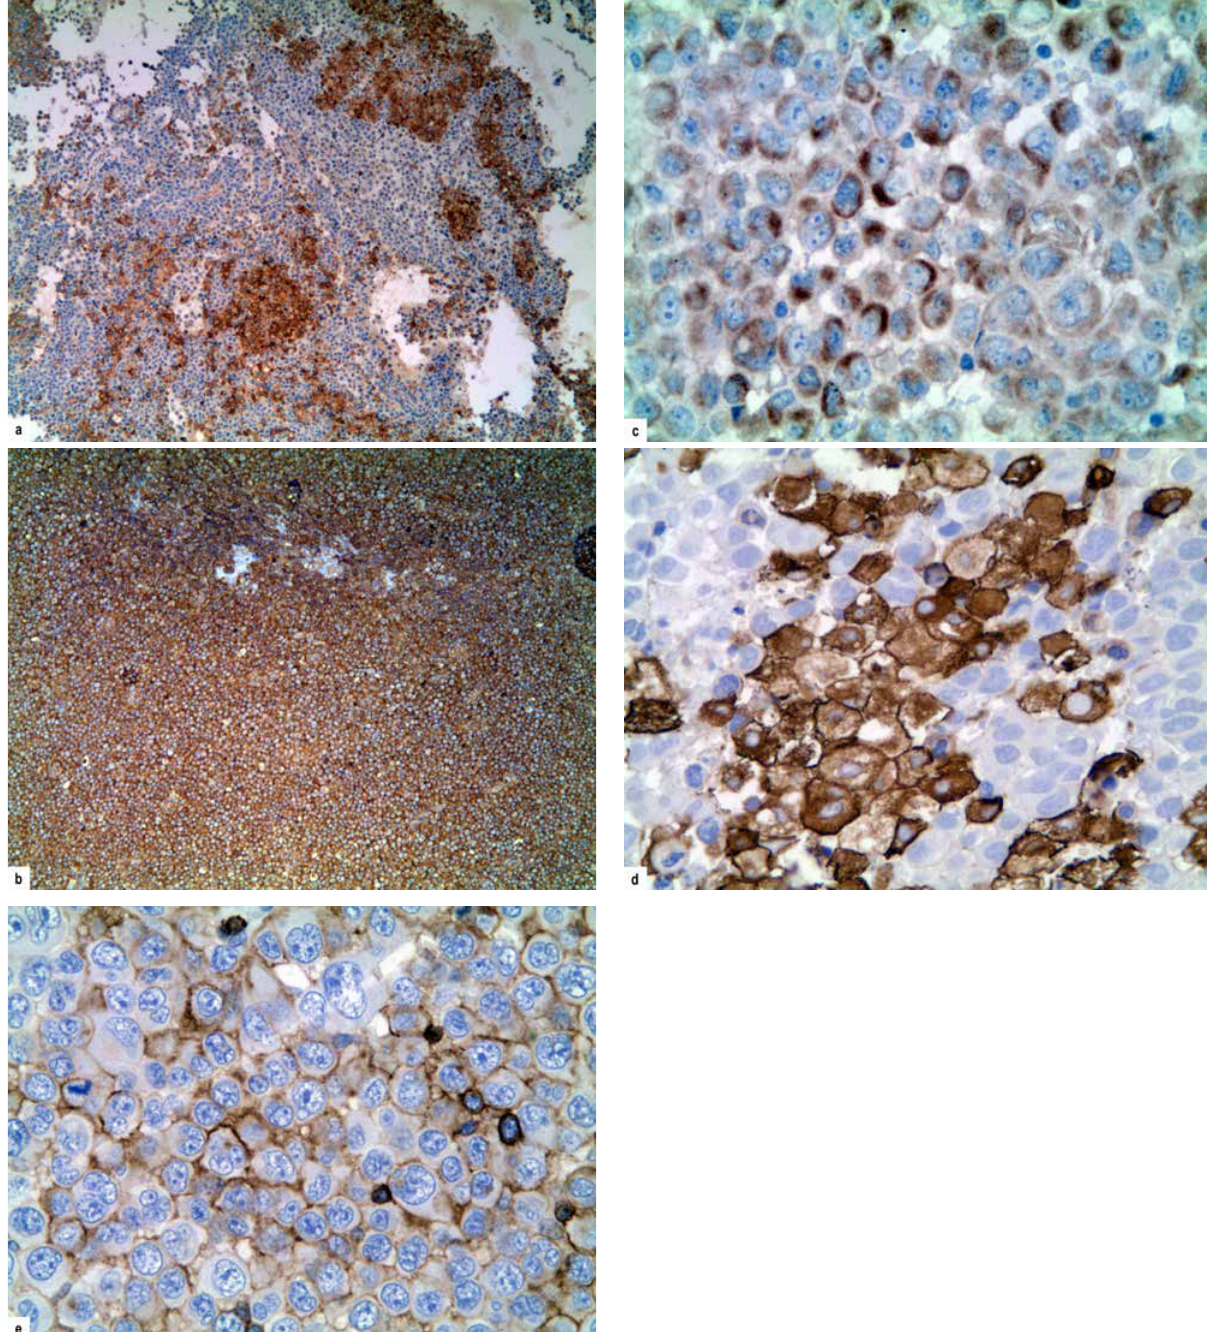
Figure 3: Tumor cells were positive for a) CD33 (x50), b) CD34 (x50), c) CD13 (x200), d) CD163 (x200), e) LCA (x200). diagnosis of T/NK cell lymphoma or blastic plasmacytoid dendritic cell neoplasm (BPDCN). A diagnosis of undif- ferentiated carcinoma or melanoma can be eliminated using the same approach. Extramedullary localizations of chronic myeloproliferative diseases without blastic crises occur mainly in the lymph nodes and are characterized by a lack of CD34-positive cells showing blast morphology. Pseudotumors created by erythromyeloid metaplasia